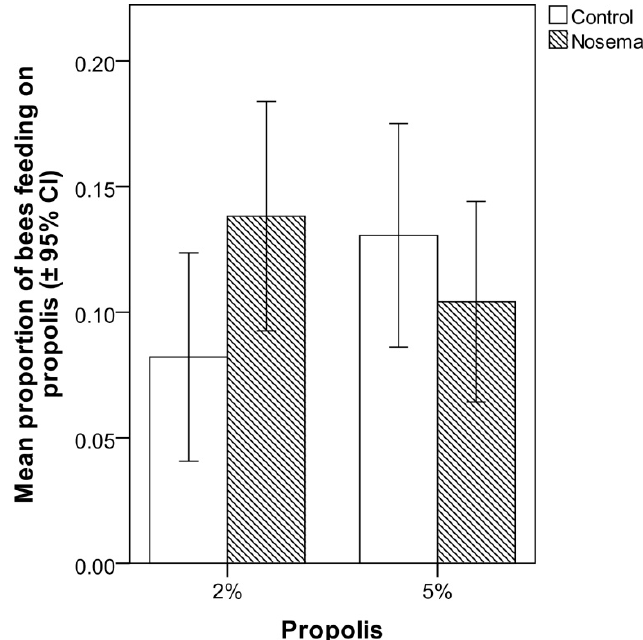
Figure 5. Mean proportion (± 95% CI) of honey bees ( Apis mellifera ) in Nosema ceranae -infected and control groups that chose to feed on the candy with 2% or 5% propolis in comparison with candy without propolis in the scan test; differences between treatments were not significant (GLMM, p > 0.05). Insects 2020 , 11 , x FOR PEER REVIEW